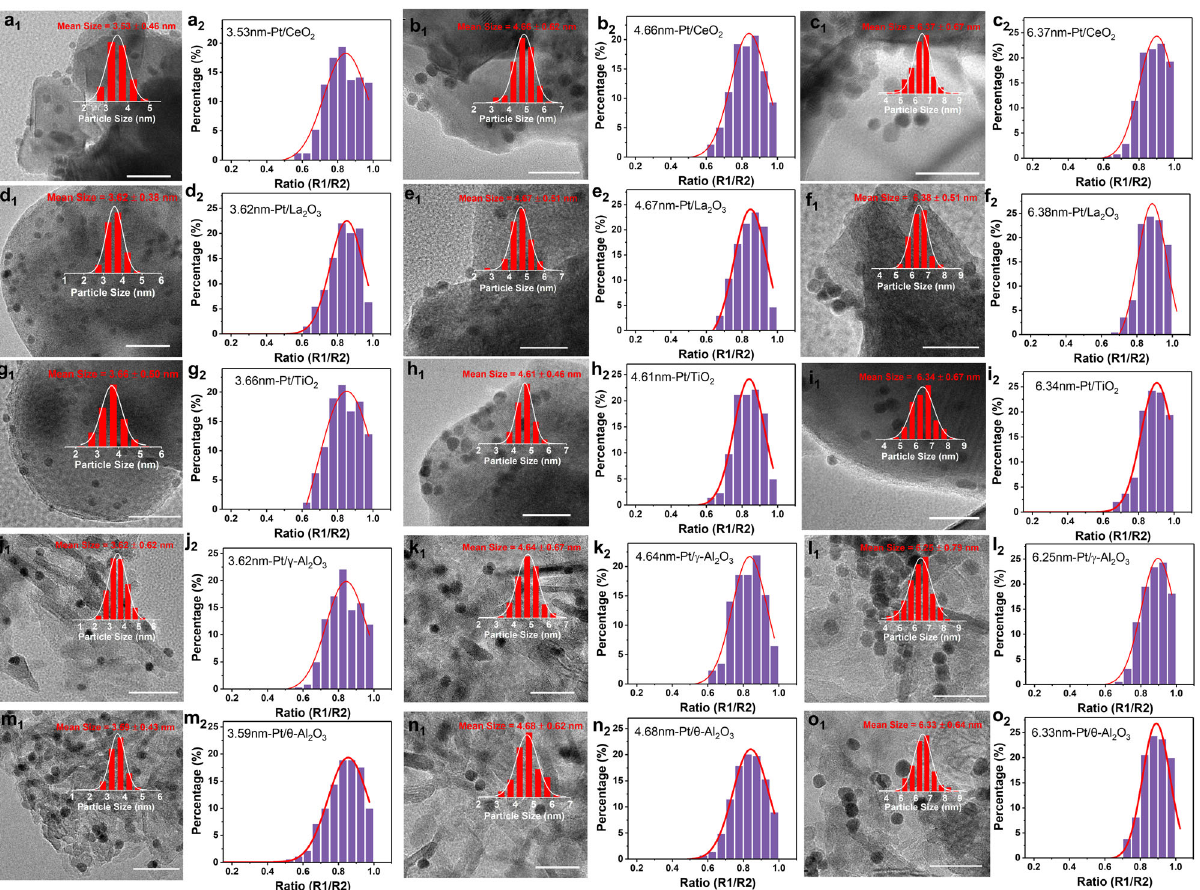
Fig. 4 Structure characterization of Pt-based catalysts with varied size. Representative HRTEM images ( a 1 – o 1 ) of as-synthesized Pt/CeO 2 ( a – c ), Pt/ La 2 O 3 ( d – f ), Pt/TiO 2 ( g – i ), Pt/ γ -Al 2 O 3 ( j – l ), and Pt/ θ -Al 2 O 3 ( m – o ) catalysts with varied Pt particle sizes and its corresponding ratio of R1/R2 ( a 2 – o 2 ). a 3.53 nm-Pt/CeO 2 . b 4.66 nm-Pt/CeO 2 . c 6.37 nm-Pt/CeO 2 . d 3.62 nm - Pt/La 2 O 3 . e 4.67 nm-Pt/La 2 O 3 . f 6.38 nm-Pt/La 2 O 3 . g 3.66 nm-Pt/TiO 2 . h 4.61